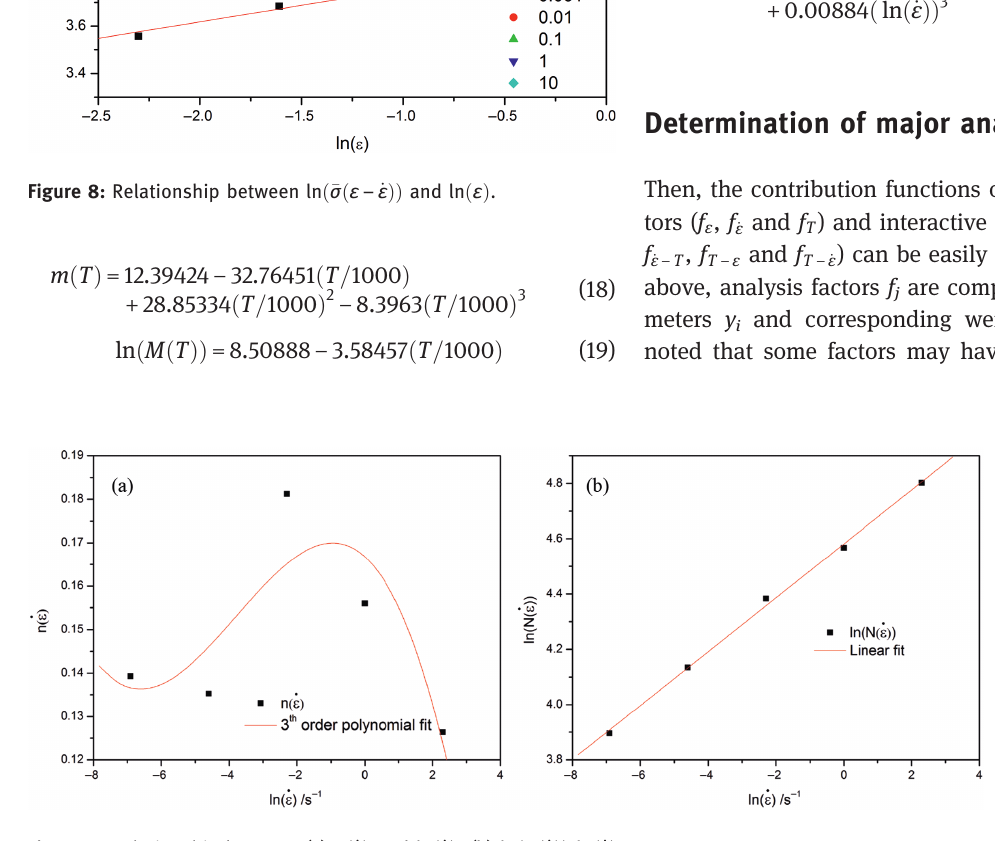
Figure 9: Relationship between (a) n ð _ ε Þ and ln ð _ ε Þ ; (b) ln ð N ð _ ε ÞÞ -ln ð _ ε Þ